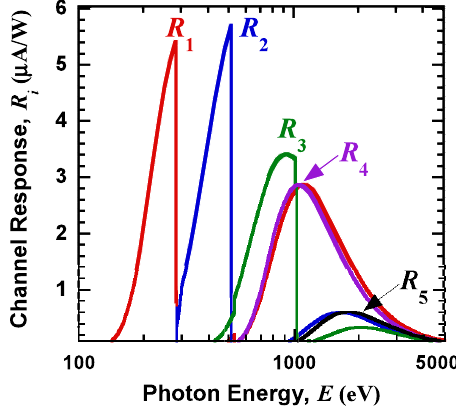
FIG. 1. A representative set of response functions, ð E Þ ; . . . ; R ð E Þ , as a function of incident x-ray energy E , for R 1 5 the filtered-XRD Z diagnostic. The sharp features correspond to characteristic x-ray absorption edges in the upstream filters and the XRD photocathodes. At low x-ray energies the responses together form three energy-selective, sensitivity bands (spectral ‘‘cuts’’) which, however, overlap at higher x-ray energies and decrease by roughly another order of magnitude as E ! (cid:3) 30 keV [Ref.